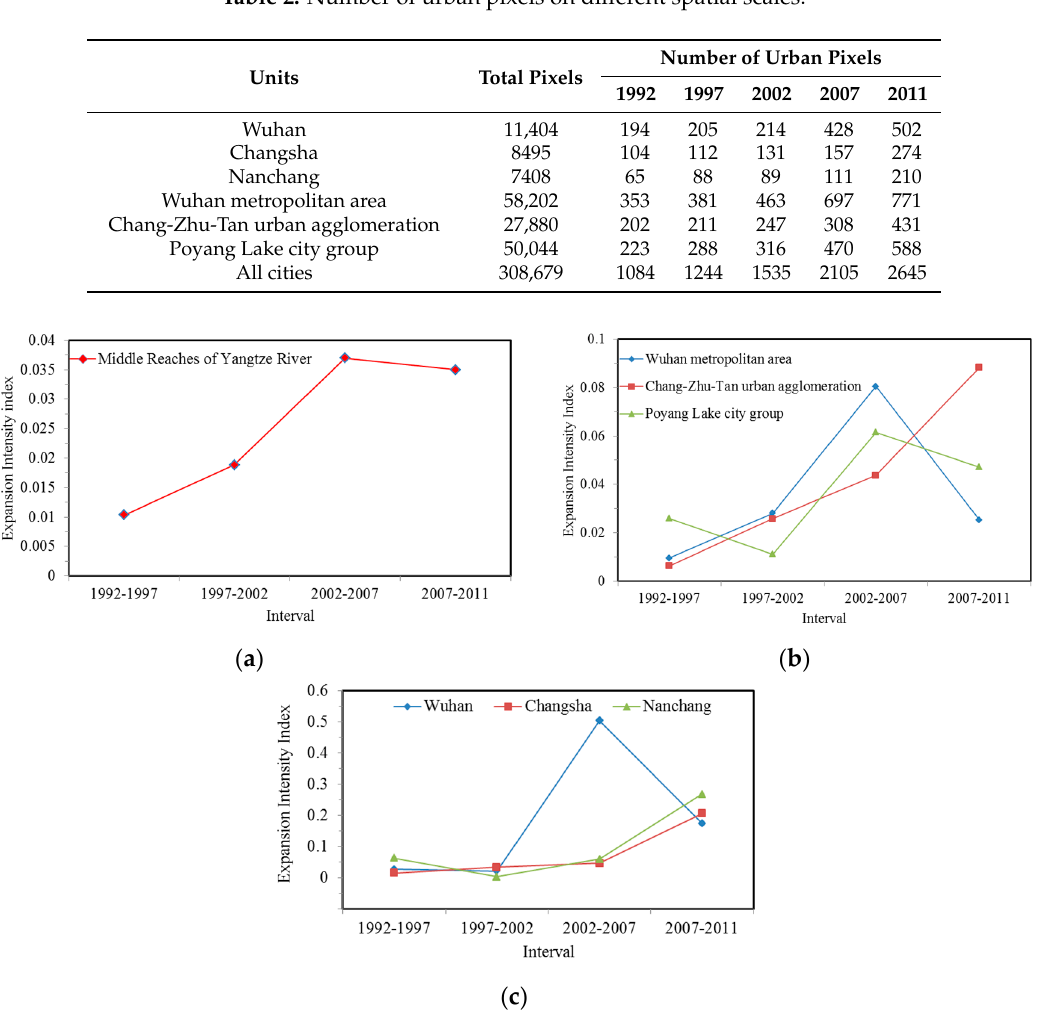
Figure 7. Changes in urban expansion intensity over different time periods: ( a ) the overall city cluster, ( b ) the urban agglomeration, and ( c ) the provincial cities. Table 2. Number of urban pixels on different spatial scales.